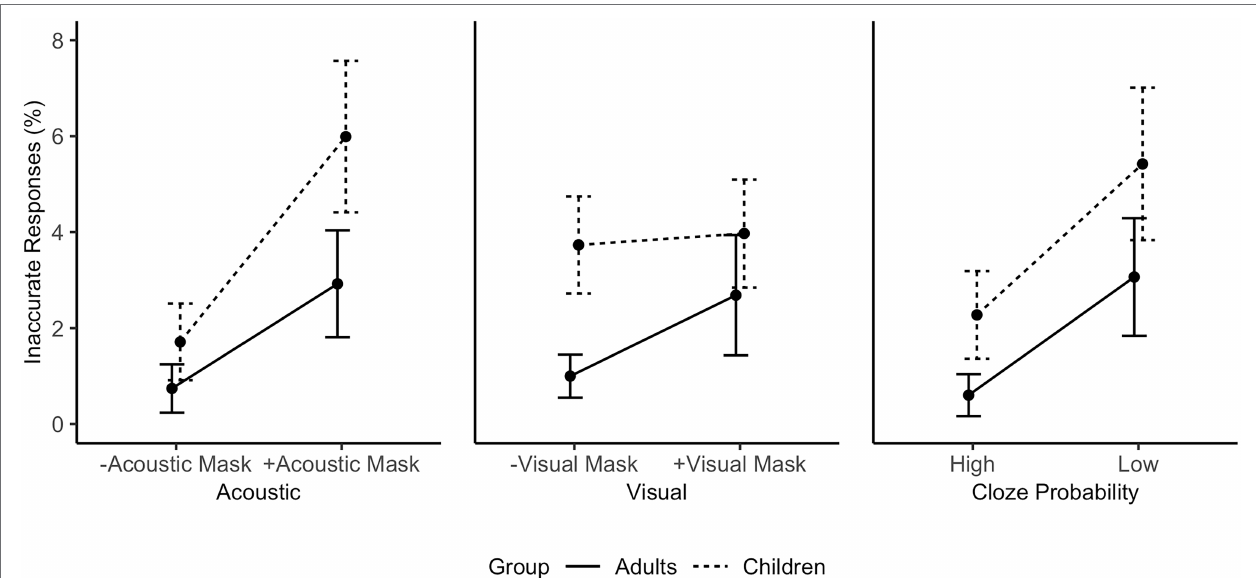
FIGURE 3 | Individual main effects on subjects’ mean response accuracy in % averaged by Age Group based on the raw data (from left to right: Acoustic Mask Effect, Visual Mask Effect, Cloze Probability